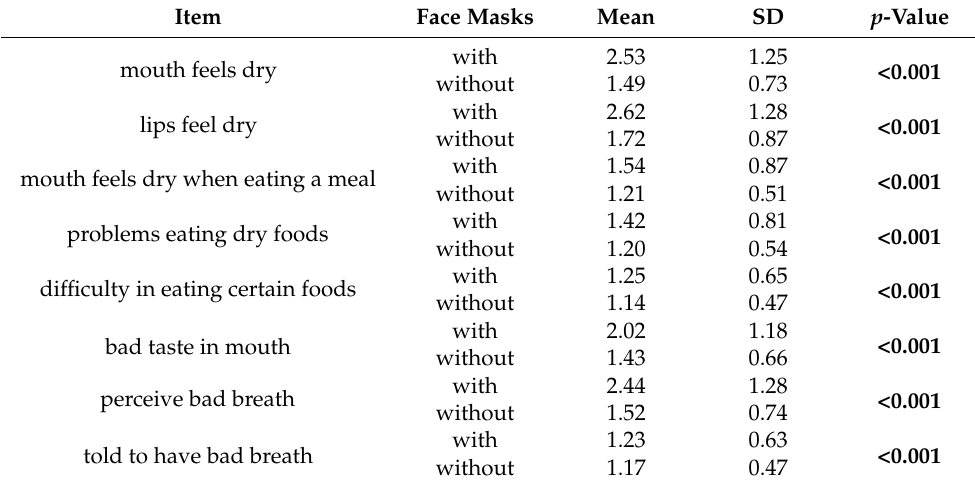
Table 1. Descriptive results regarding self-reported dry mouth and